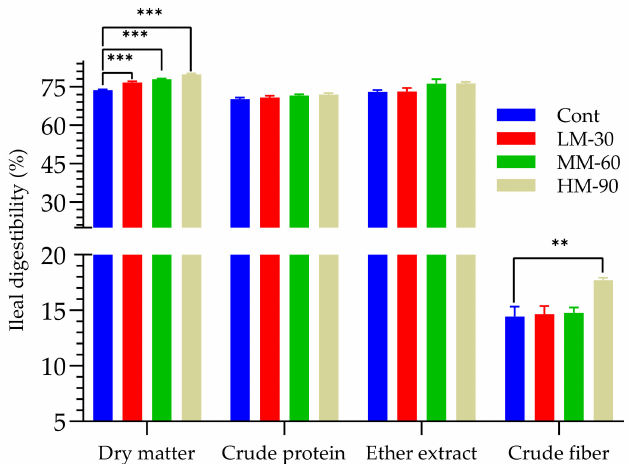
Figure 1. Effect of β -mannanase supplementation on ileal digestibility of nutrients in broilers fed low energy diets. Cont (ME 3100 kcal/kg): without β -mannanase; LM-30 (ME − 30 kcal/kg), MM-60 (ME − 60 kcal/kg) and HM-90 (ME − 90 kcal/kg) were supplemented with 200, 400, and 600 mg/kg β -mannanase, respectively. Statistical difference from corresponding control value for a given parameter is annotated by: ** p < 0.01, *** p < 0.001.